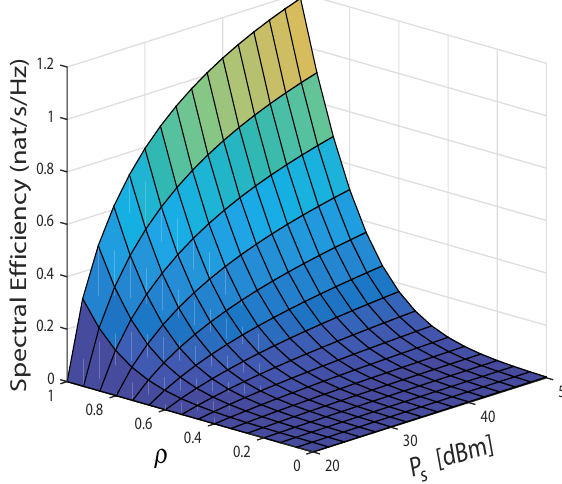
Figure 2. Spectral Efficiency vs. P λ s = 25 / km 2 and λ p = 5 / km 2